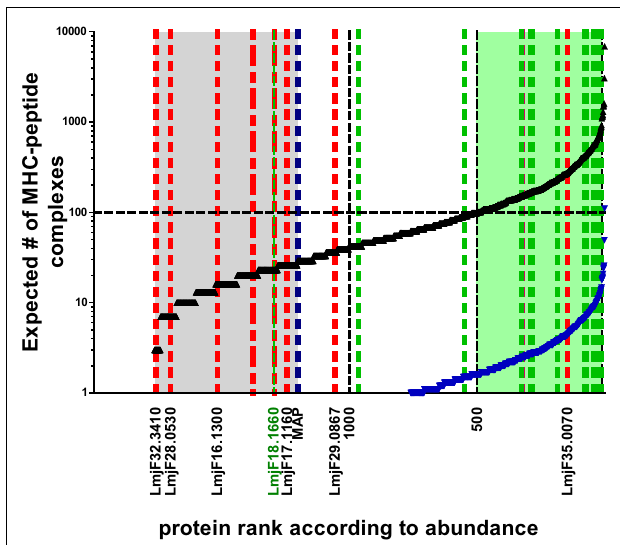
FIGURE 2 | Expected number of individual MHC–peptide complexes depending on protein abundance .The black curve indicates expected number of complexes assuming protein copy number is most determining. Blue curve indicates lower boundary of the model basing expected number of complexes on the assumption that all protein are first degraded to peptides.The likelihood of complex formation for a peptide derived from the average size protein (52kDa) is thus reduced 36-fold [i.e., the average number of predicted epitopes deducted from Herrera-Najera et al. (30)]. Green shaded area in plot: proteins above the threshold of 100 MHC–peptide complexes when sampled by 10 5 MHC molecules assuming one binding peptide per protein. Area shaded in gray: proteins with ranks below that of lysosomal membrane acid phosphatase (MAP; blue dotted line) for which the corresponding molecule number per parasite was experimentally shown to be non-stimulatory forT cells. Green dotted lines indicate ranks of proteins with experimental evidence ofT cell recognition (in ascending order GRP78, HSP83, Histone H-2, STI-1, CSP-B, Glu synthetase, ATP synthase, LACK, LeIF,TSA, gp63, KMP-11, HSP20, 60S ribosomal protein, nucleoside hydrolase, amastin, SMT, and γ -glutamylcysteine synthetase = LmjF18.1660). Blue dotted line indicates lysosomal membrane acid phosphatase (MAP) for which the corresponding molecule number per parasite was experimentally shown to be non-stimulatory forT cells. Red dotted lines refer to the rank of proteins identified in silico to contain candidate epitopes by Herrera-Najera et al. (30) (again in ascending order, LmjF35.0070, LmjF29.0867, LmjF17.1160, LmjF16.1300, LmjF28.0530, and LmjF32.3410), or John et al. (28) (red stippled line: PI-3 Kinase like protein,